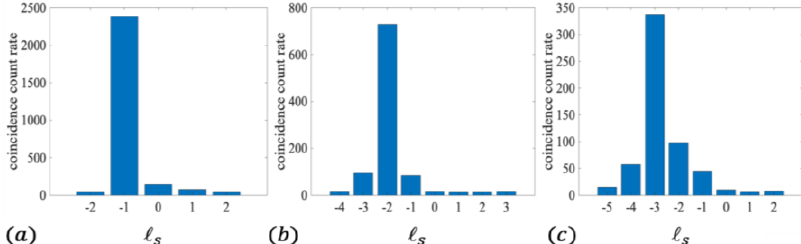
Fig. 1 . Coincidence count rates as a function of detection modes azimuthal number  𝑠 . The cases of the pump beam with a )  𝑝 = 1, b)  𝑝 = 2, с)  𝑝 =